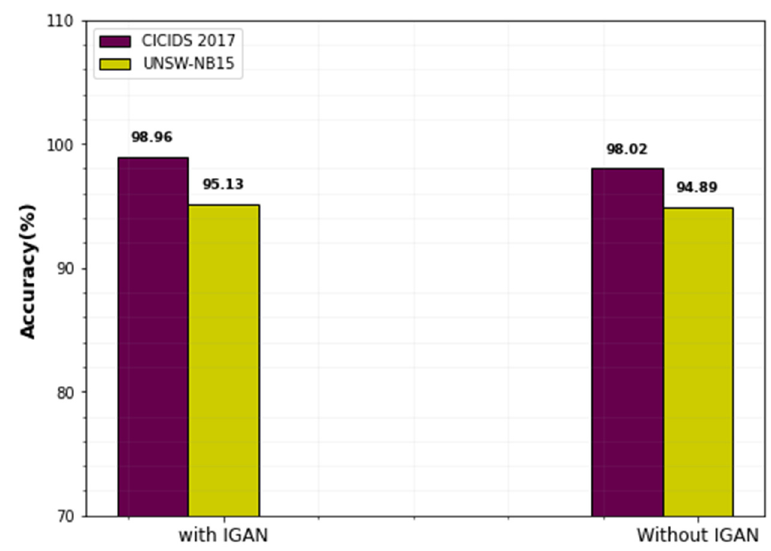
Figure 15. Analysis of data imbalance technique.